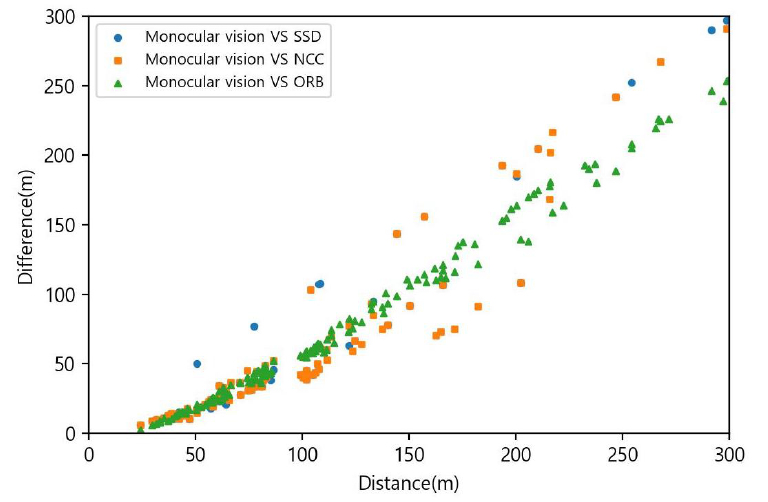
Figure 25. Difference in distance calculation between monocular and stereo vision.